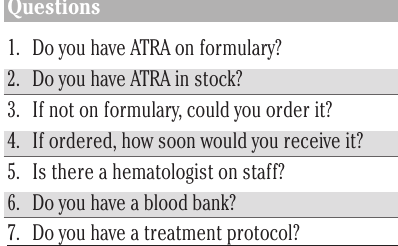
Table 1. The survey questions for each of the 23 acute promyelocytic leukemia treat- ment centers.